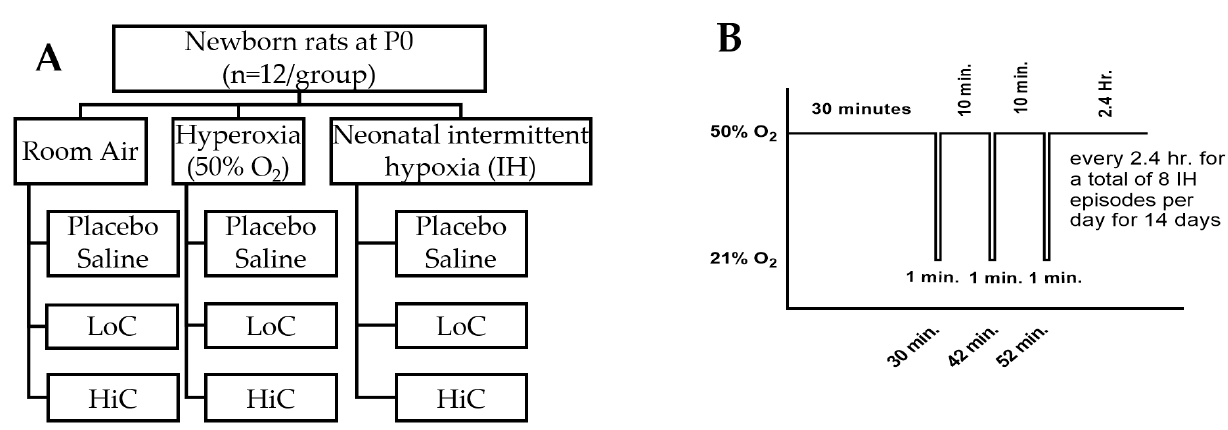
Figure 13. A : Experimental Design. LoC (standard caffeine daily IP doses of 20 mg/kg on P0/5 mg/kg on P1-P14). HiC (high caffeine daily IP doses of 80 mg/kg on P0/20 mg/kg on P1-P14). B : Neonatal intermittent hypoxia paradigm.